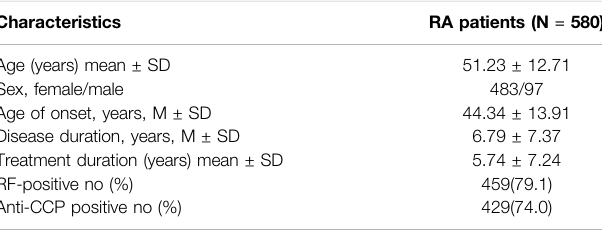
TABLE 1 | The main demographic and clinical characteristics of rheumatoid arthritis patients. Characteristics RA patients (N =